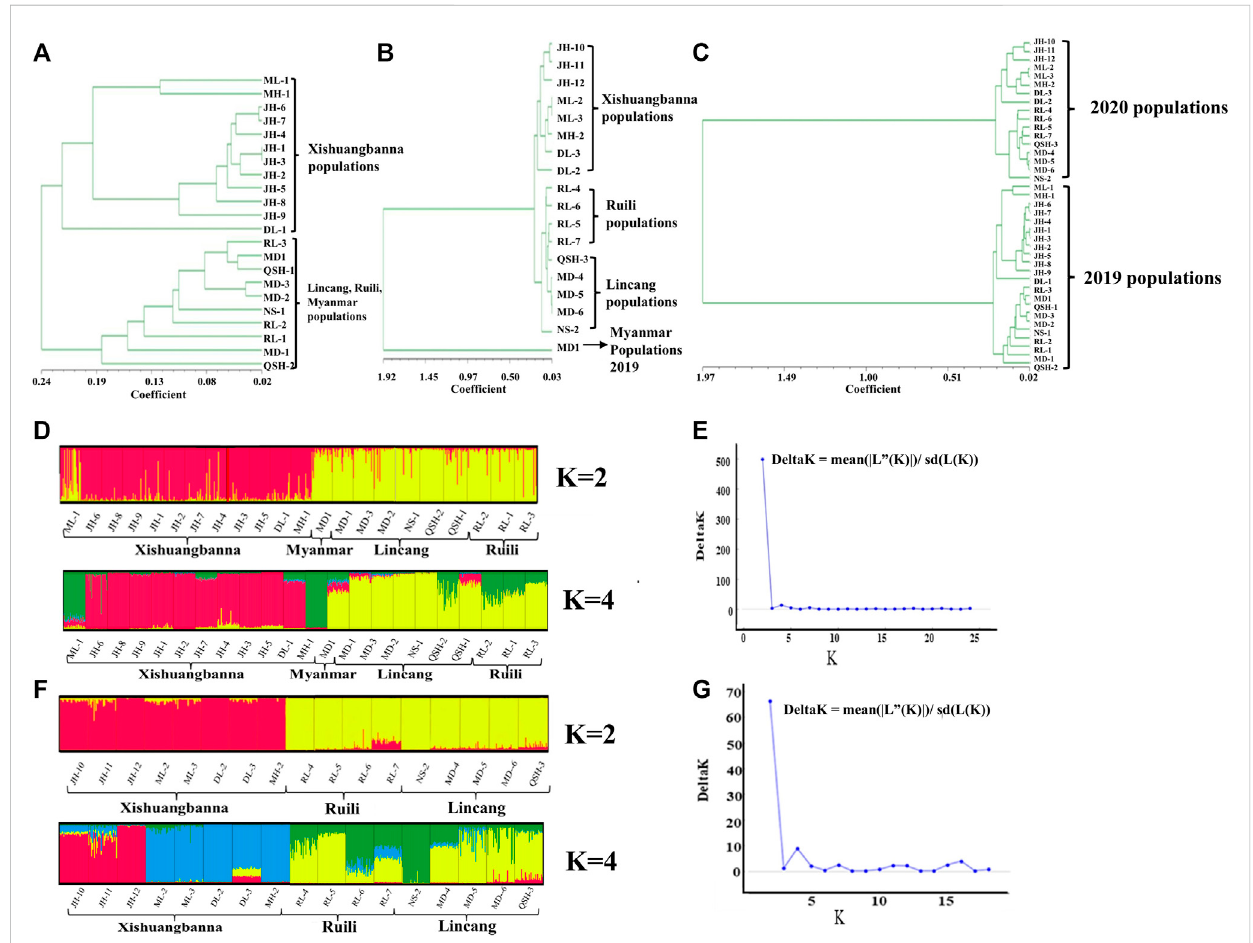
FIGURE 2 UPGMA (A) , (B) , (C) and STRUCTURE (D) , (E) , (F) , (G) cluster analysis. Figure 2A represents the UPGMA cluster analysis results of the populations collected in 2019; Figure 2B represents the UPGMA cluster analysis results of Myanmar population collected in 2019 and populations collected in the border area of Yunnan Province in 2020; Figure 2C the conjoint analysis of collected populations in 2019 and 2020; Figures 2D, F show the STRUCTURE clusteranalysisofthepopulationscollectedin2019(K=2,K=4)and2020(K=2,K=4)respectively.Thetwoblacklinesrepresentapopulation,and each color represents the percentage of individuals belonging to this cluster. The STRUCTURE software calculates that the optimal k value of the populations collected in 2019 and 2020 is 2 (represented by red and yellow bars respectively). Figures 2E, G represent K values of the populations collected in 2019 and 2020 assessed via Evanno et al. ’ s Δ K